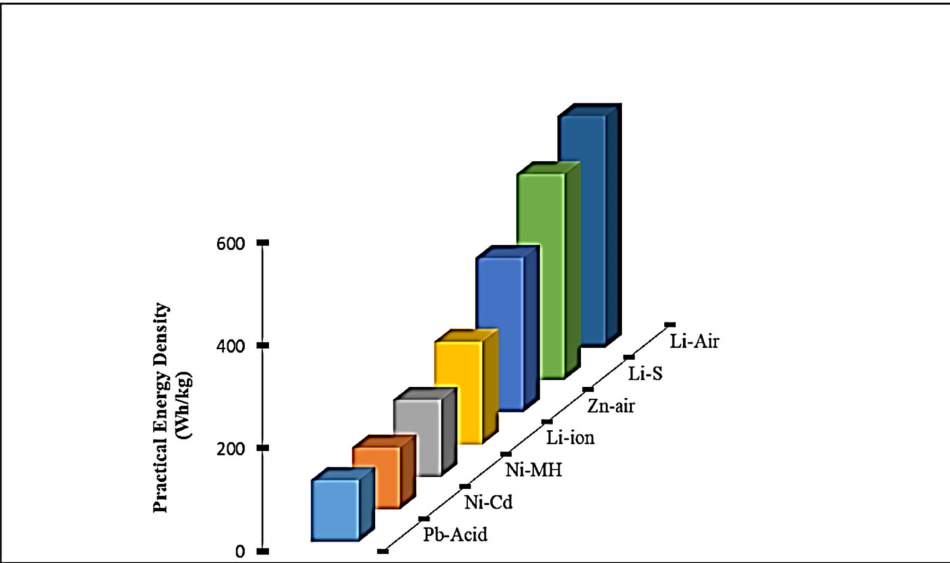
Figure 4. Different types of rechargeable batteries with respect to energy density (Wh kg − 1